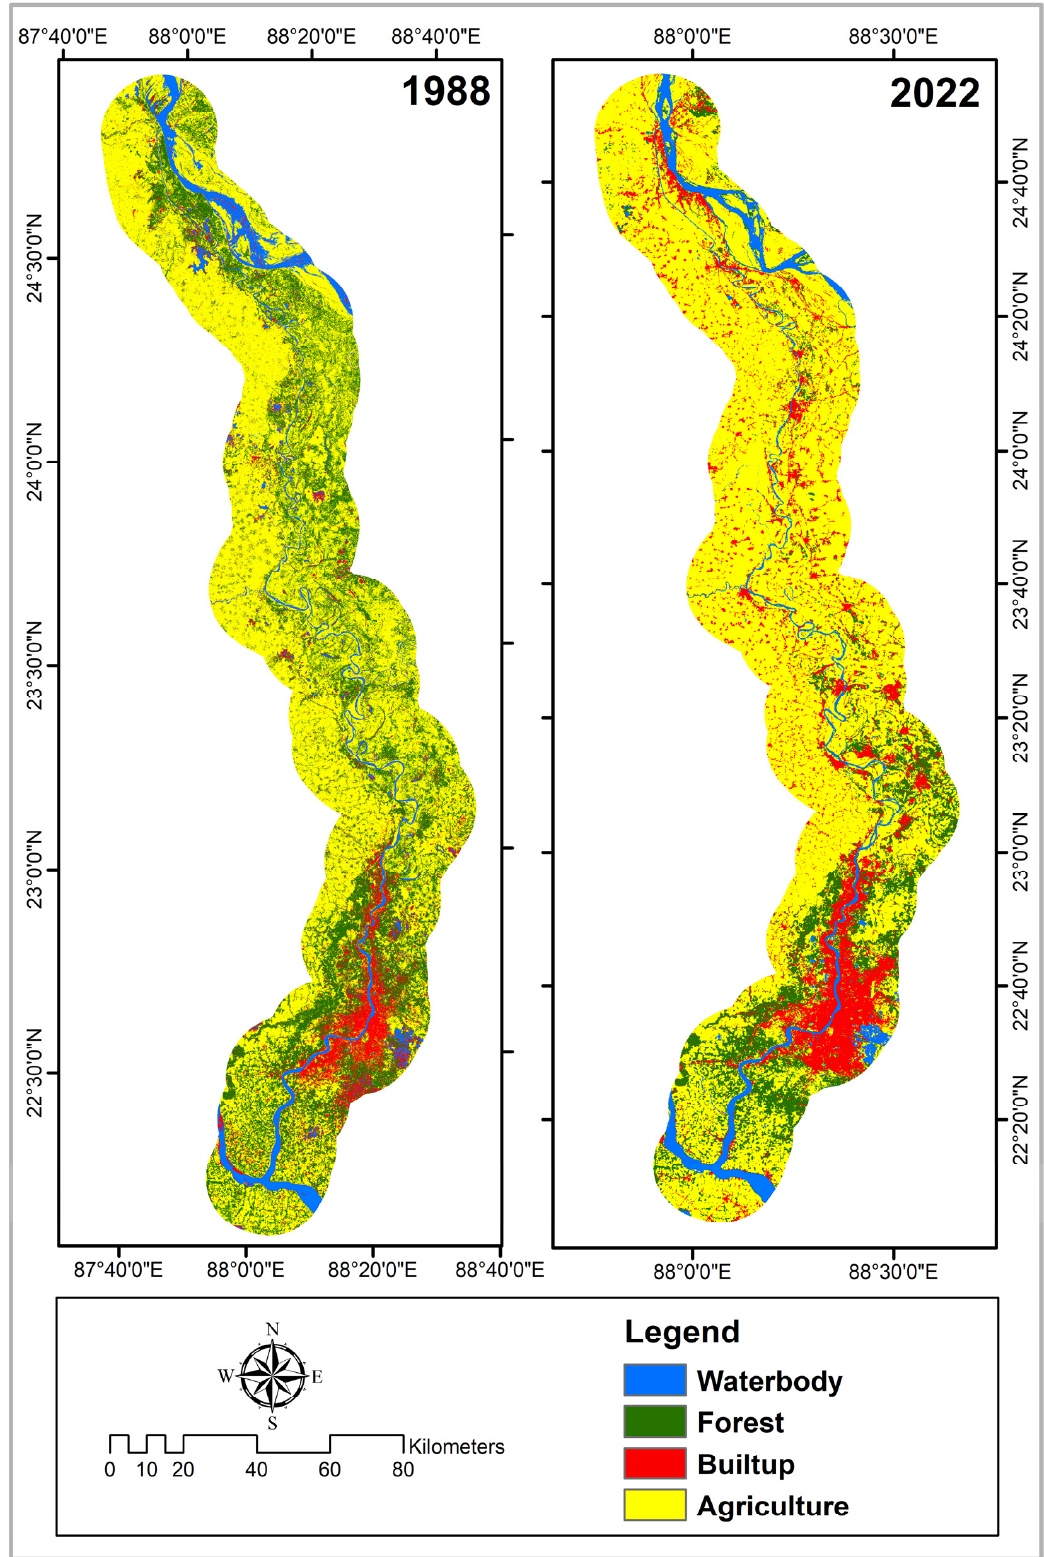
Figure 4. LULC map of the study area for 1988 and 2022.